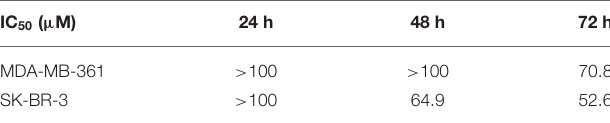
TABLE 1 | A list of IC 50 values of actein on MDA-MB-361 and SK-BR-3 cells. IC 50 ( µ